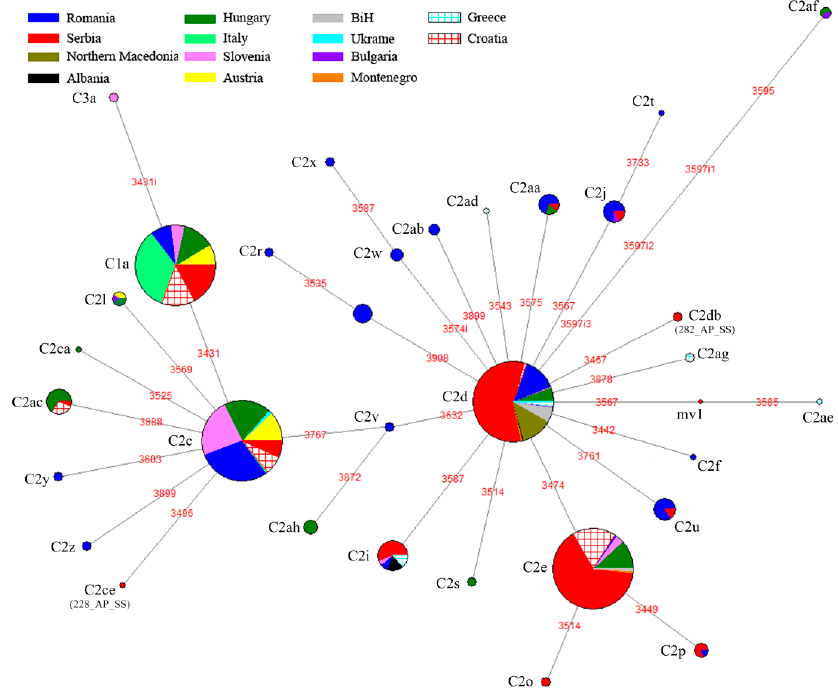
Figure 3. Median-joining phylogeographic network of 1937 mtDNA haplotypes detected in the 14 populations (Serbia- Romania, Austria, Hungary, Croatia, Slovenia, Bulgaria, B&H, Albania, North Macedonia, Montenegro, Greece, Ukraine and Italy) based on the variability of the tRNA leu - cox2 intergenic region (motifs in red). Positions with insertions are marked with the suffix i . The size of the node is proportional to the number of individuals. The origin of each sample is shown in the legend. Serbia-population set represented by the literature and GenBank data for Serbia and 8 localities from our dataset (L, V, S, T, S, Vr, DS and FG). The overall distribution of haplotype groups of 14 countries is presented in Table